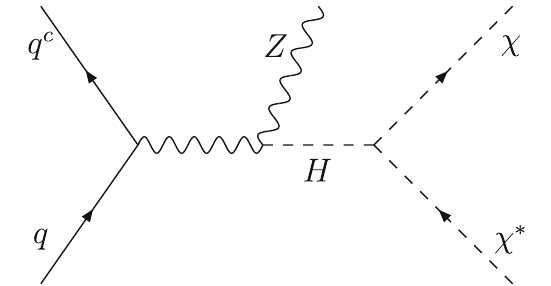
Fig. 4 Mono- Z production at the LHC associated with the emission of a dark matter pair